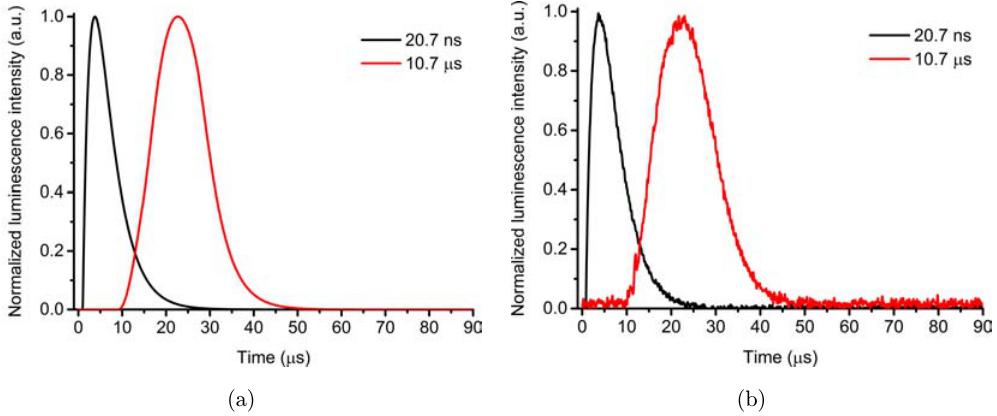
Fig. 3. Temporal pro¯les for 1 O 2 luminescence with two di®erent pulse widths excitation: (a) simulated curves using the equation models with (cid:3) D ¼ 4 (cid:1) s, (cid:3) T ¼ 2 (cid:1) s, (cid:1) D ¼ 0 : 76, (cid:1) T ¼ 0 : 9 12,15 ; and (b) the measured results.